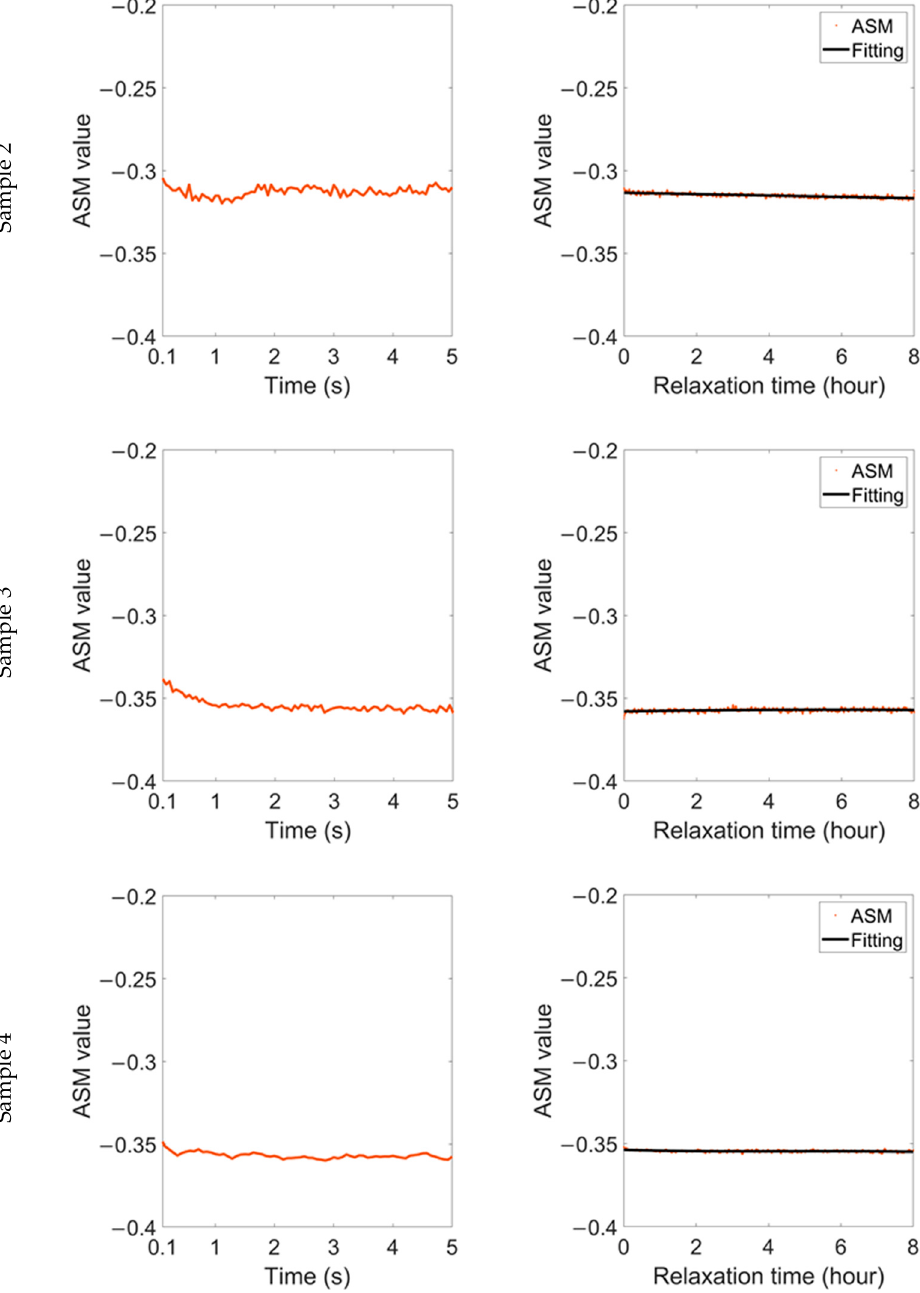
Figure 9. Variation in ASM parameter during relaxation time after 1.5% strain was removed after the samples had been in plastic status for 45 days.